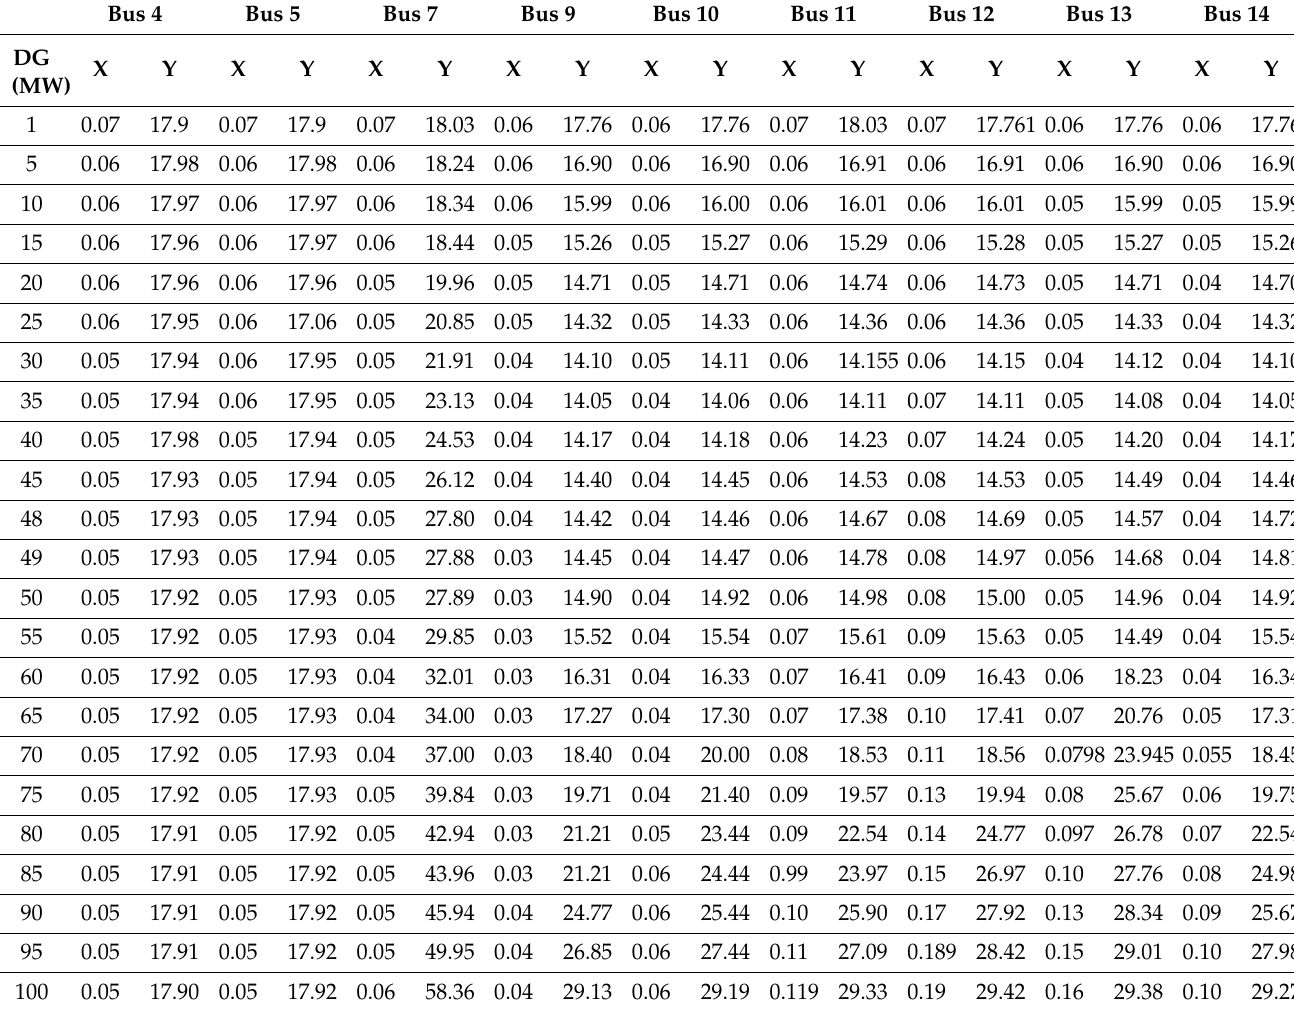
Table 6. Validation table of the algorithm with various DG penetration at all load buses. For the 14-bus system of IEEE.